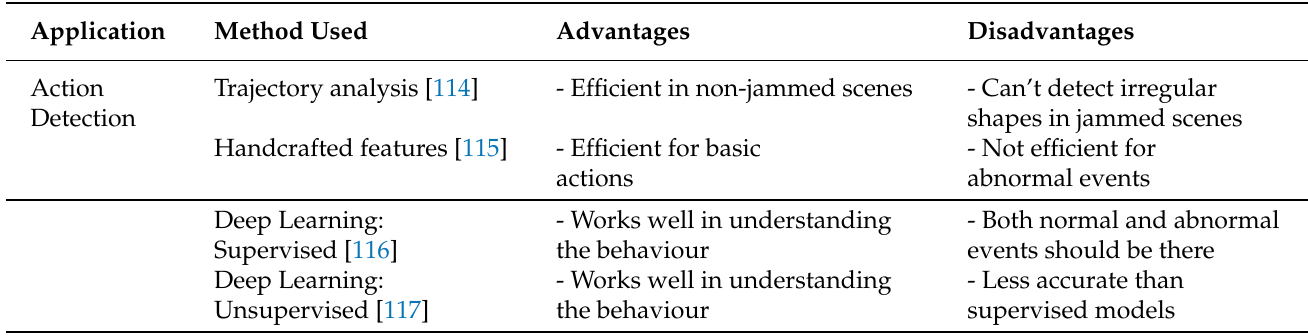
Table 9. Comparison between methods used in application.